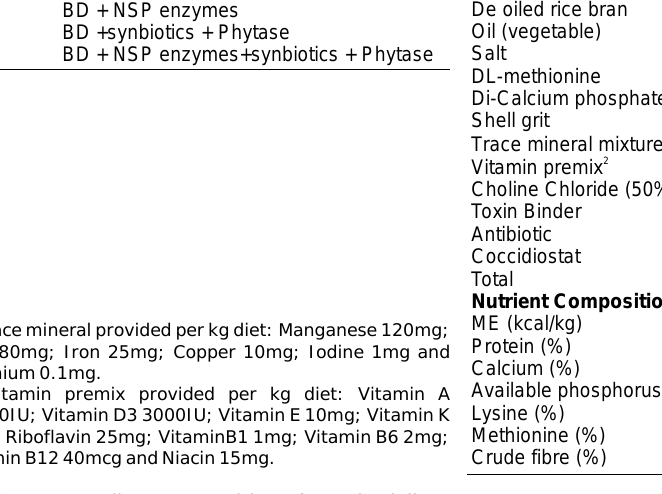
Table-3. Ingredient composition of standard diets Ingredient